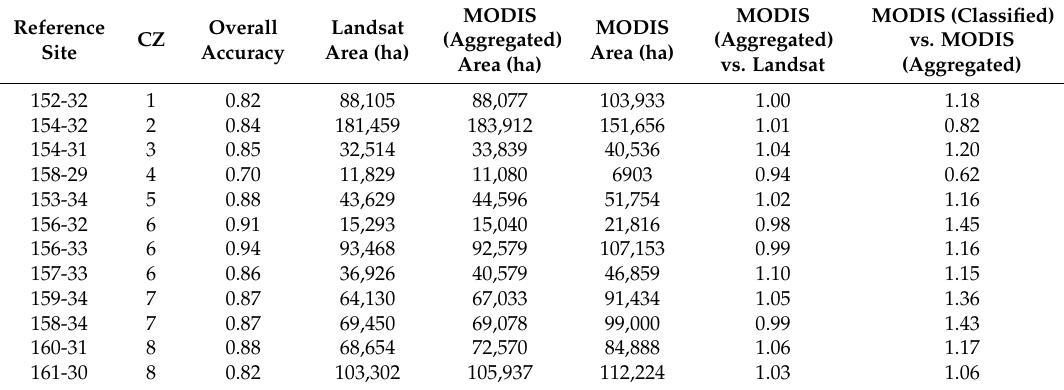
Table 3. OA of the MR-iCE received in the different reference sites (labelled by the WRS-2 paths and rows, ordered by the respective classification zone, CZ), plus (i) the area extents of the Landsat-based HR-iCE; (ii) the HR-iCE aggregated to MODIS pixel size; and (iii) MR-iCE received for the reference sites, as well as area comparisons between (i) and (ii), and (ii) and (iii). Comparatively high deviations from the average are given in bold numbers. Combined information on the geographic location of the reference sites and the classification zones (CZ) is given in Figure